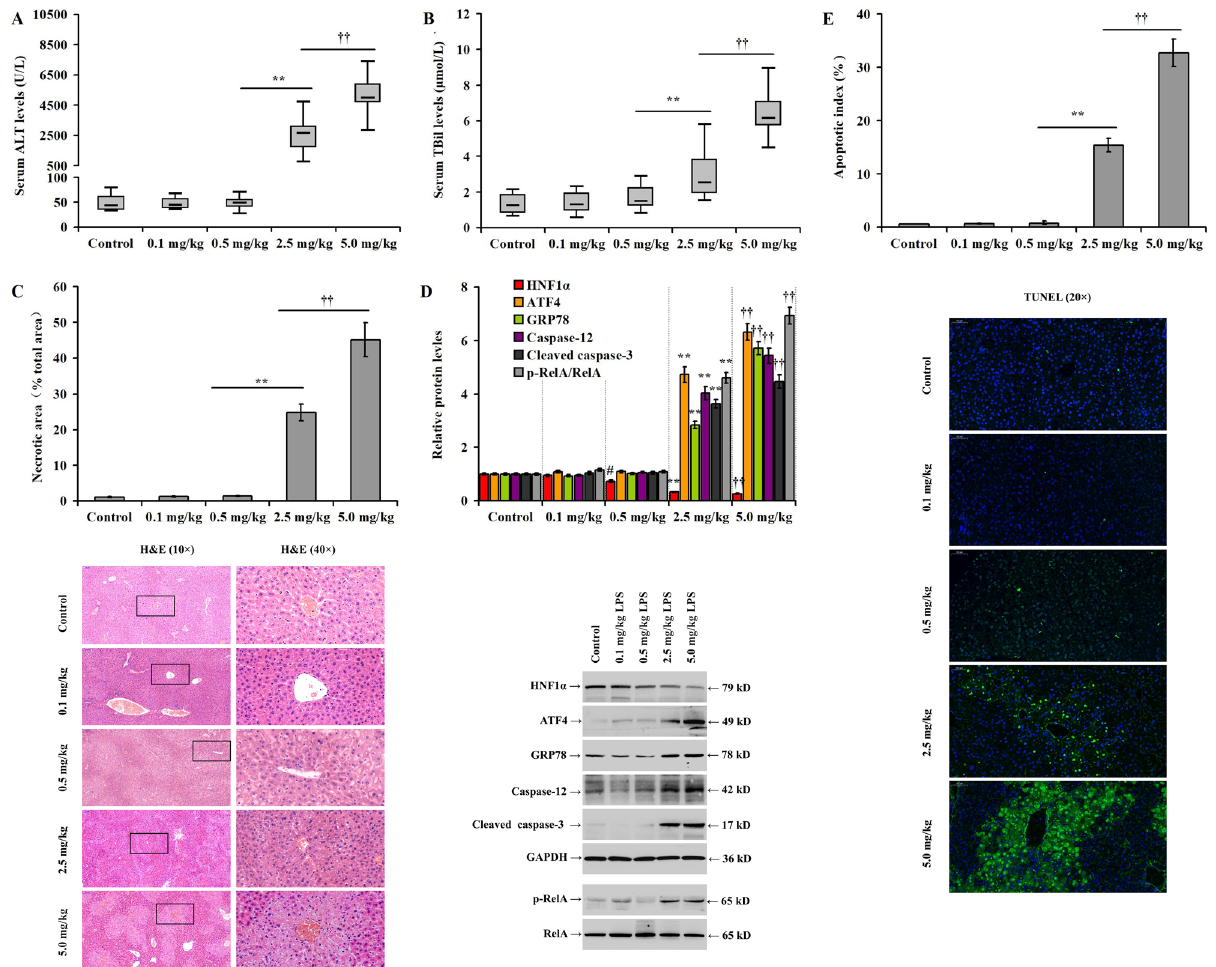
representing the impact of different LPS doses on the level of serum TBil in mice; ( C ) histopathological changes in mice liver in the different experimental groups; ( D ) bar chart and representative western blotting detecting the impact of different LPS doses on protein expression between the different experimental groups; and ( E ) hepatocyte apoptotic index measured by TUNEL staining. # p < 0.05 versus the control group. ** p < 0.01 versus the 0.5 mg/kg group. †† p < 0.01 versus the 2.5 mg/kg LPS